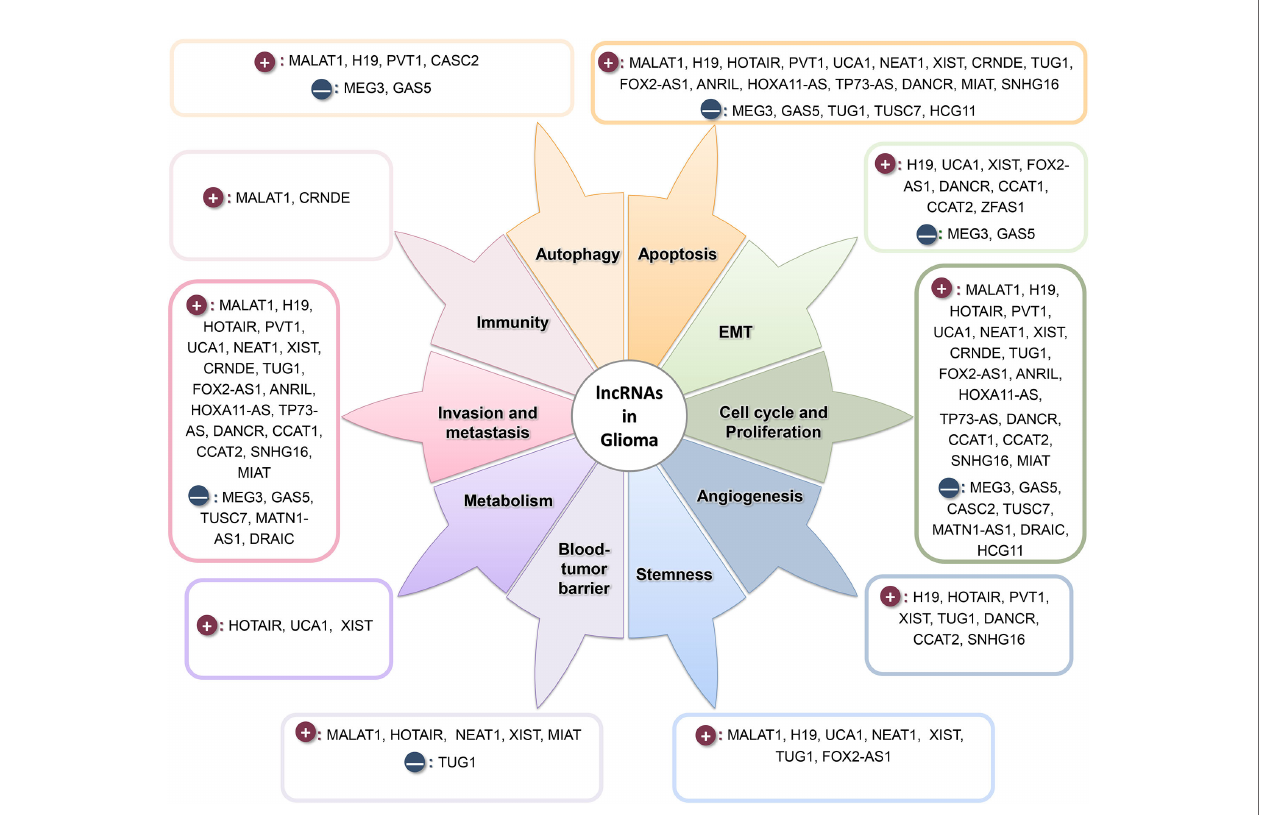
FIGURE 2 | lncRNAs play a prominent role in various stages of tumor formation and progression. Dark-red circles show the oncogene lncRNAs, and navy circles show the tumor suppressor